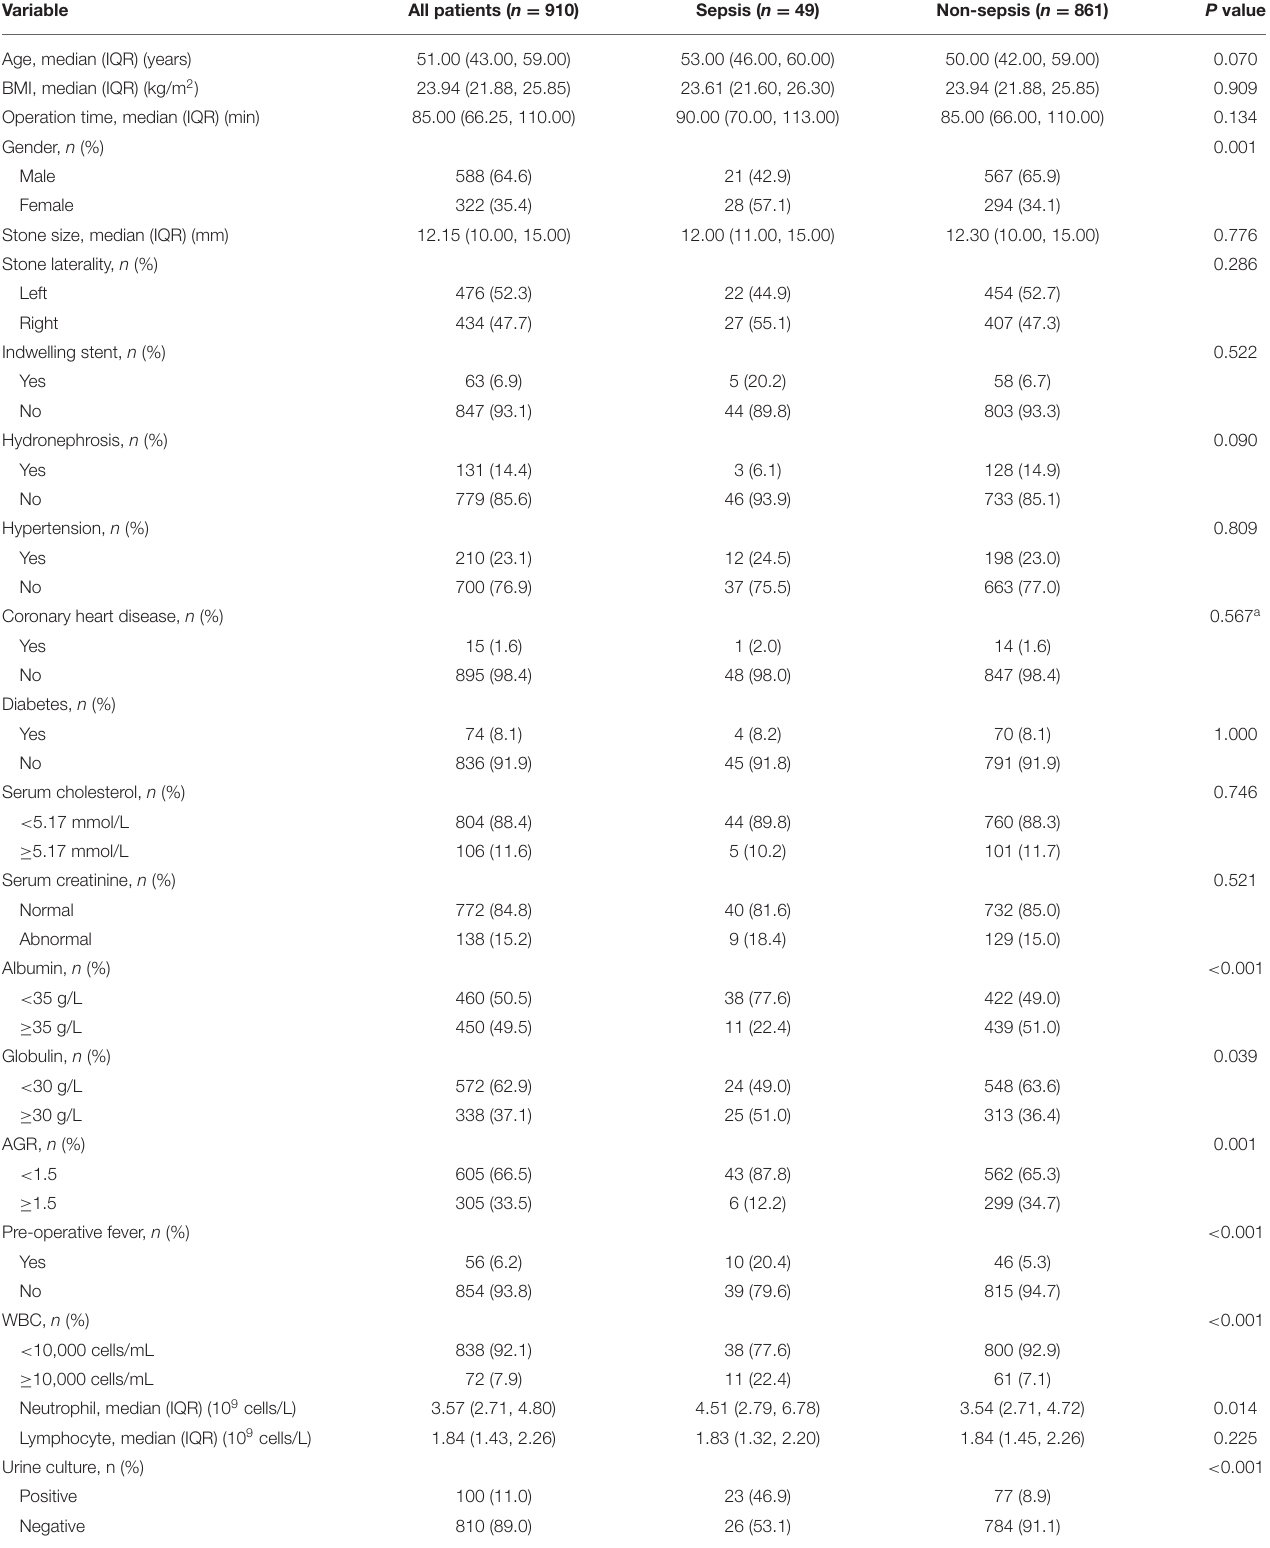
TABLE 1 | Basic characteristics of including